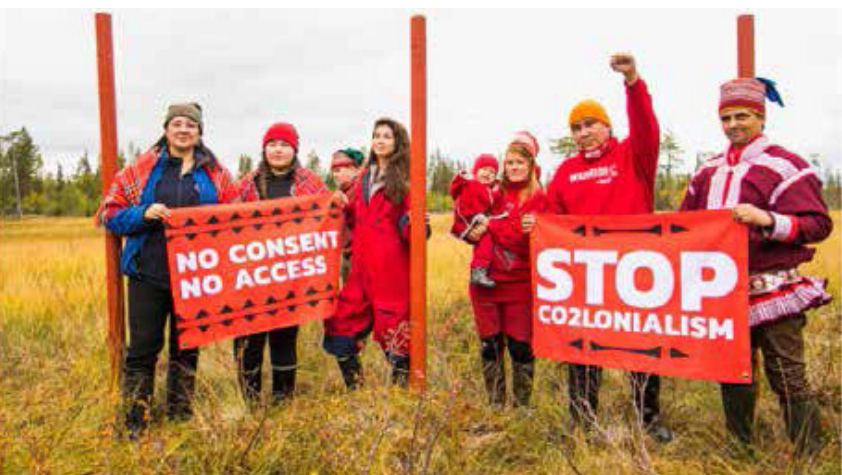
Figure 3. Cree leaders join an anti‐Arctic Railway demonstration of the Sámi in Finland. Source: APTN National News